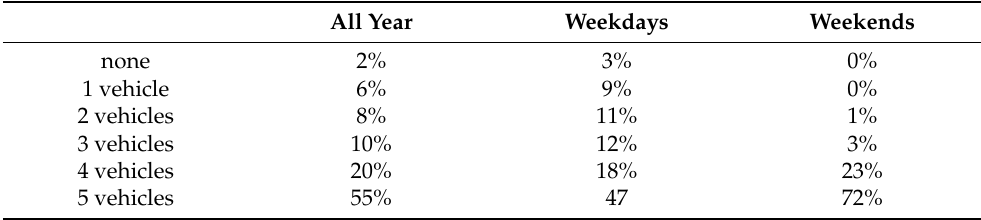
Table 4. Percentage of time that vehicles were available to charge/discharge in the one-year historical dataset.